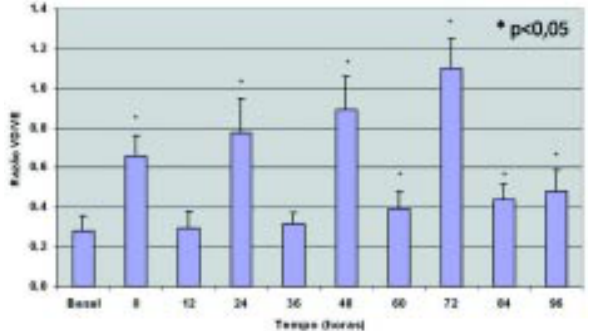
Fig. 3 - Razão de pressão VD/VE nos quatro grupos de estudo. Notar a intermitência da razão a cada período de 12 horas. Valores = média ± desvio padrão. *p<0,05 vs. Basal